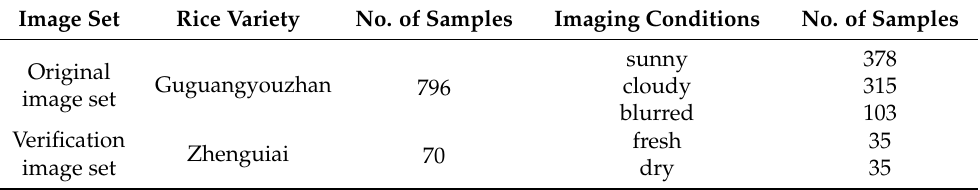
Table 1. Detailed information of image